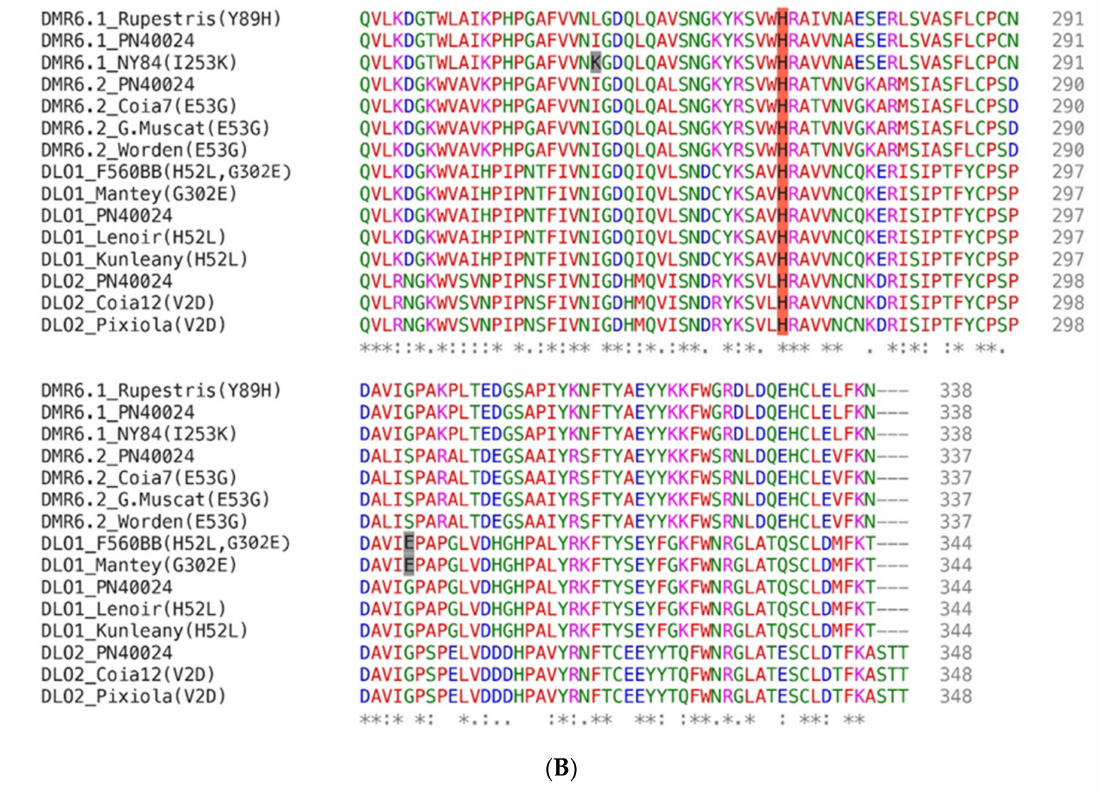
Figure 2. Amino acid sequence alignments. Amino acids important for the 2-DOG oxidase function (e.g., the NYYPPCP stretch responsible for binding the 2-oxoglutarate substrate and the iron-binding HDH triplet) are highlighted in red. The DLO-DMR6 characterizing motif WRDY/FLRL is highlighted in yellow; R124 within the WRDY/FLRL motif, and R108 of the Arabidopsis thaliana DMR6-1 sequence were shown to be essential for the function and are as well highlighted in yellow [80]. Amino acids that are changing in the different grapevine variants are indicated within parenthesis and their position is highlighted in grey on the sequence. ( A ) CLUSTALW alignment of bonafide DMR6 (in bold) and DLO (underlined) proteins from different species. C.sativus_Cucsa.193360 and C.sativus_Cucsa.273300 were identified as AtDMR6 orthologues in Cucumis sativus by Schouten at al. (2014) [14], although no experimental proof is provided. Bonafide DMR and DLO proteins are: Zea mays ZmFNSI-1/ZmDMR6, A. thaliana AtDMR6, AtDLO1, and AtDLO2; Solanum lycopersicon SlDMR6. The grapevine DMR6 and DLO proteins (VvDMR6.1, VvDMR6.2, VvDLO1, and VvDLO2) are those of the PN40024 reference genome. ( B ) CLUSTALW alignment of translated grapevine sequences. Abbreviations: Rupestris: V. rupestris du Lot, PN40024: Pinot noir -derived near-homozygous line, NY84: NY84.0100.05, F560BB: F560 Big Brown, G.Muscat: Golden Muscat. * (asterisk) indicates positions which have a single, fully conserved residue. : (colon) indicates conservation between groups of strongly similar properties - scoring > 0.5 in the Gonnet PAM 250 matrix. . (period) indicates conservation between groups of weakly similar properties - scoring =< 0.5 in the Gonnet PAM 250